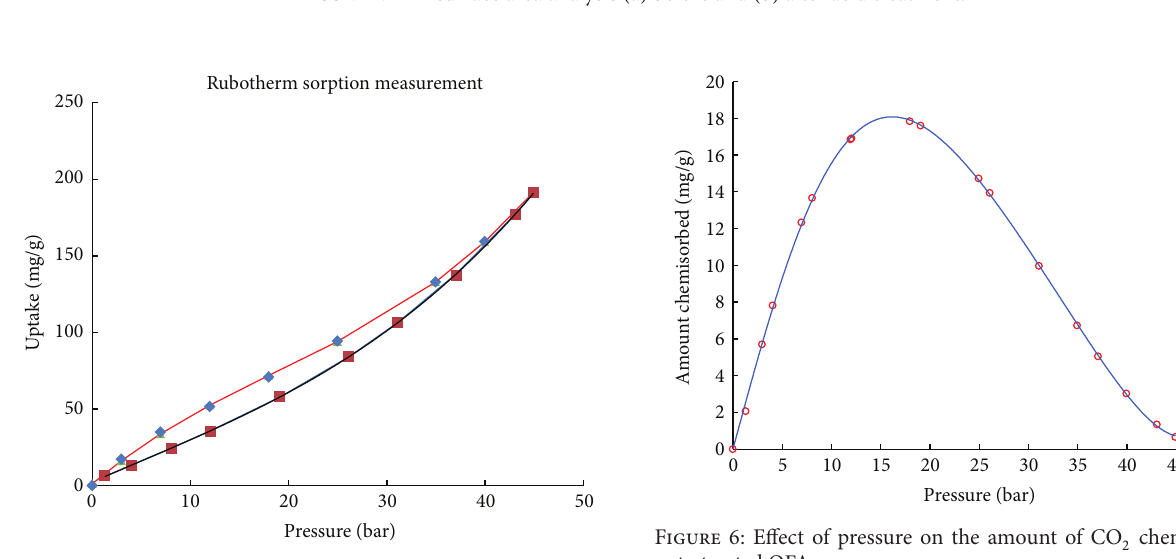
Figure 4: BET surface area analysis (a) before and (b) after acid treatment.